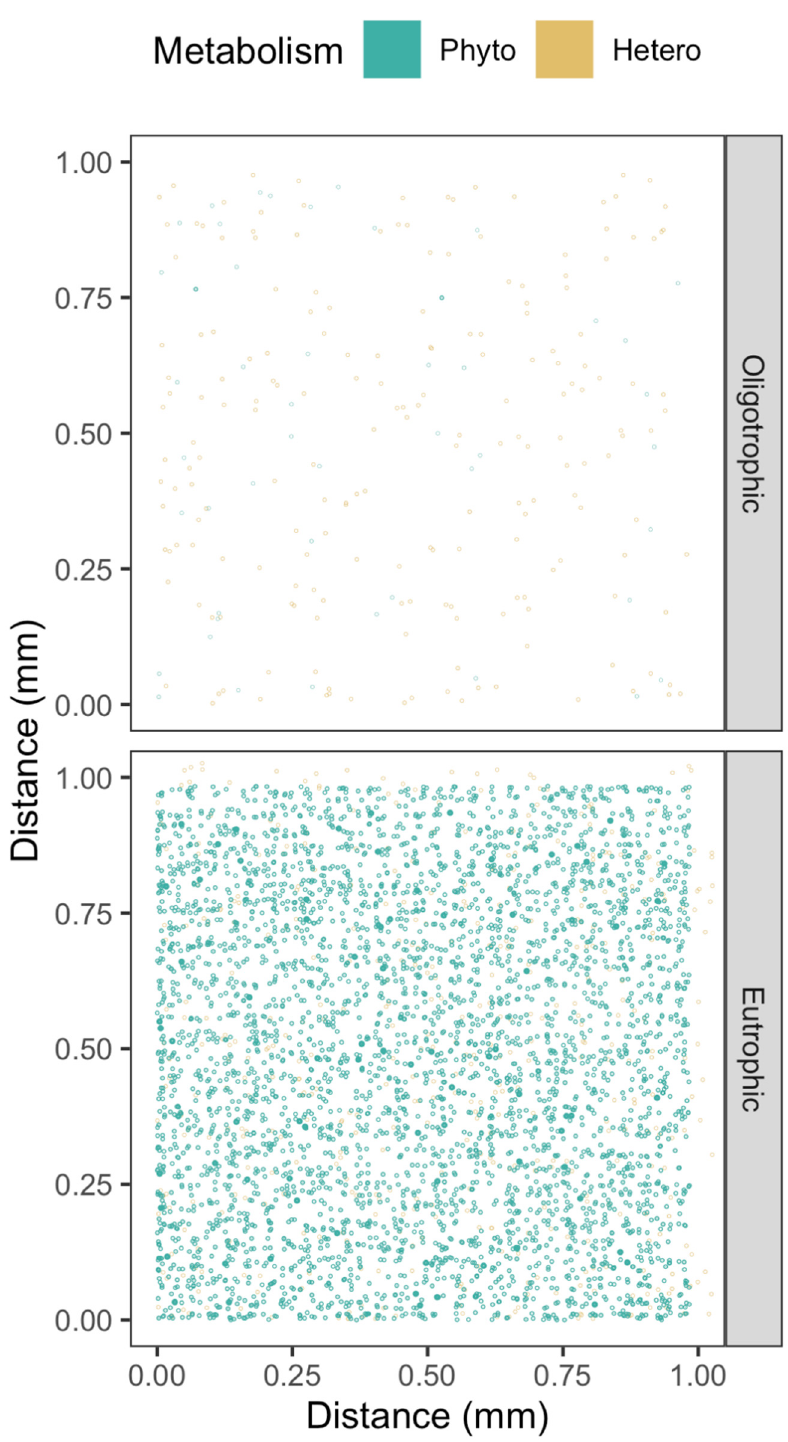
Figure 1. Phytoplankton and heterotrophic bacteria spacing from eutrophic or oligotrophic environments, with cell size on the same scaling as the 1 mm XY spatial axes. A 1 mm Z spatial axis is coded with fainter points farther back.